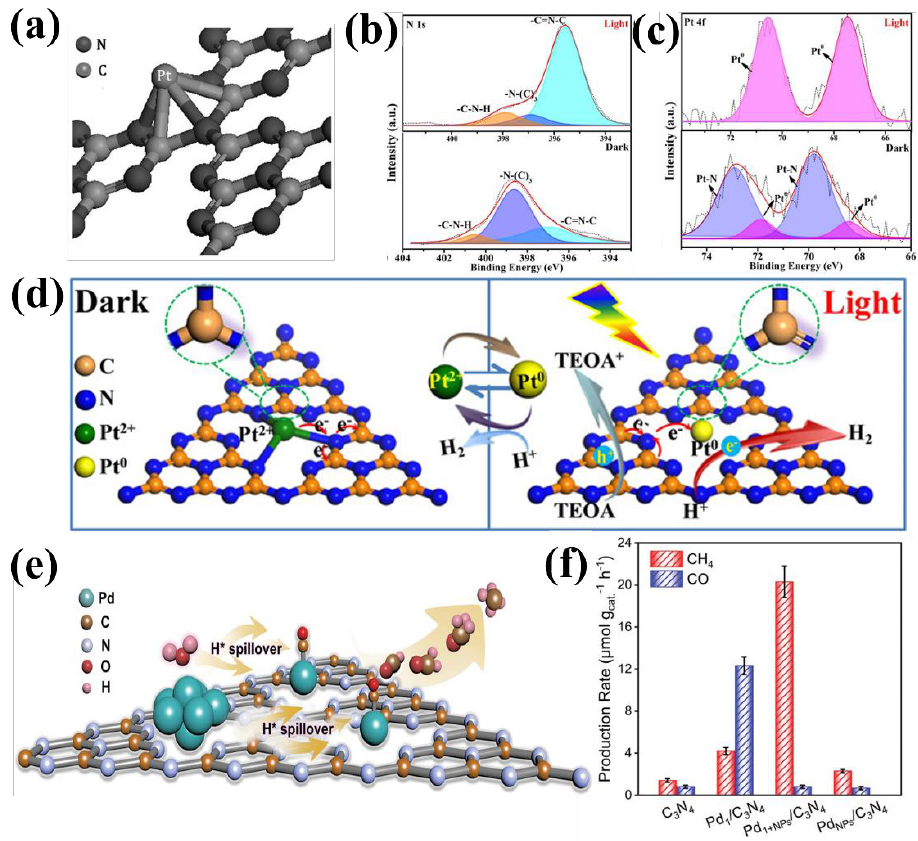
Figure 2. ( a ) Schematic models of Pt – CN [41]. ( b , c ) High-resolution SI-XPS of single-atom Pt/CN. ( d ) Illustration of charge transfer and bond variation on single-atom Pt/CN for photocatalytic H 2 evolution [42]. ( e ) The reaction mechanism for photocatalytic conversion of CO 2 to CH 4 over Pd 1+NPs /C 3 N 4 . ( f ) Production rates of CO 2 photoreduction over C 3 N 4 , Pd 1 /C 3 N 4 , Pd 1+NPs /C 3 N 4 and Pd NPs /C 3 N 4 [43].